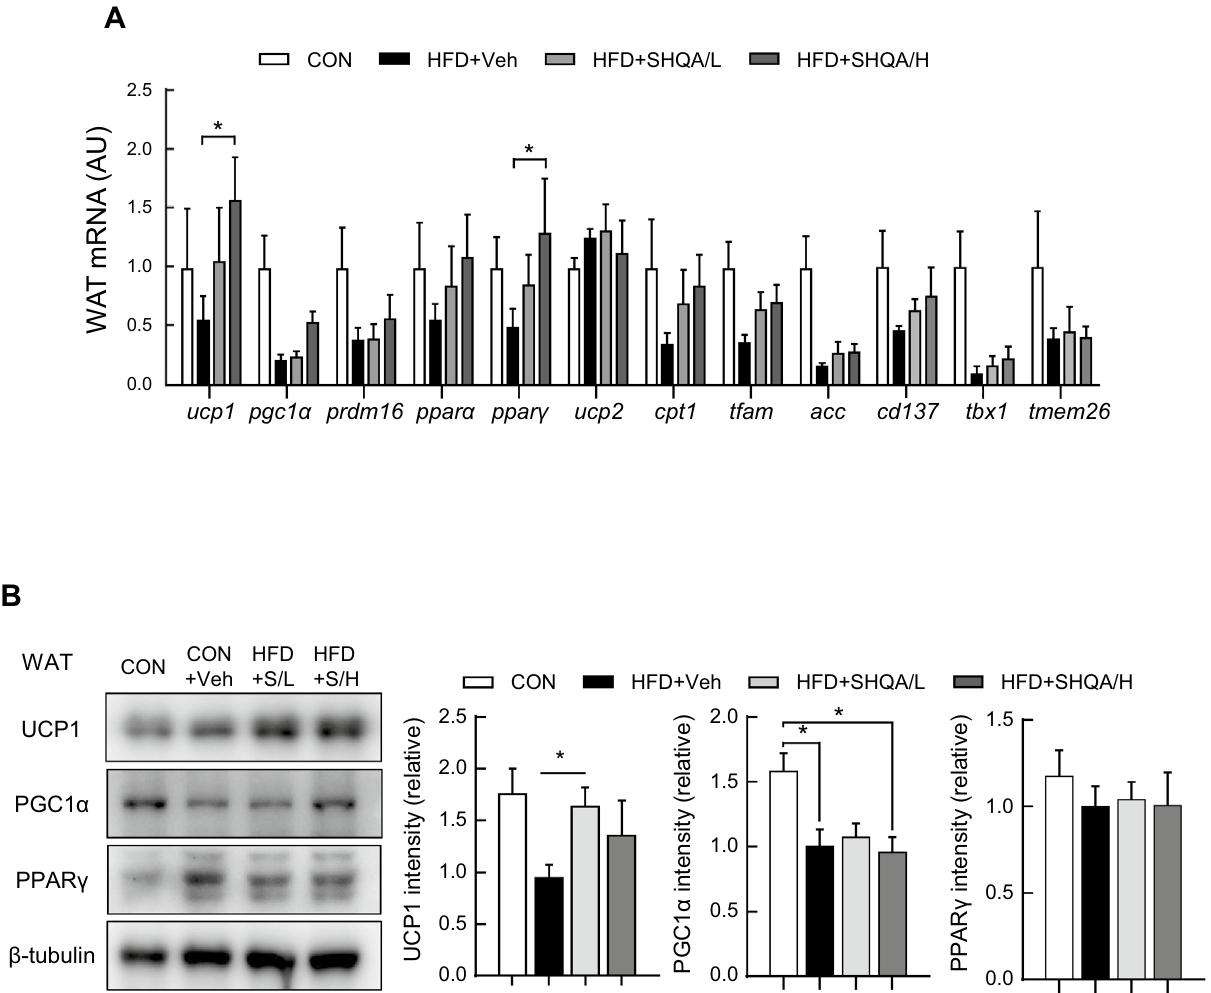
Figure 6. SHQA injection alters gene expression signature in white adipose tissues of mice. C57BL/6 mice (4 weeks old) were fed a chow diet (CON) or a HFD with the hypothalamic injection of PBS (CON or HFD + Veh, three times a week), a low dose (HFD + SHQA/L or HFD + S/L, 20 ng/µl, three times a week) or a high dose of SHQA (HFD + SHQA/H or HFD + S/H, 100 ng/µl, three times a week) for 12 weeks. The subcutaneous white adipose tissues from these mice were collected for measuring mRNA and protein levels. ( A ) mRNA expression levels of genes related to adipose tissue browning and thermogenesis were measured in white adipose tissues. ( B ) The protein levels of UCP1, PGC1α, and PPARγ were measured by western blots with representative bands shown in the figure (whole images of blot were shown in Supplementary Fig. S2). Data are expressed as mean ± S.E.M. Statistical differences between CON, HFD + Veh, HFD + SHQA/L (SHQA, 20 ng/µl), and HFD + SHQA/H (SHQA, 100 ng/µl) were determined using one-way ANOVA followed by the Tukey’s post hoc test: * p < 0.05; Statistical differences between HFD + Veh and HFD + SHQA/L in UCP1 protein were determined using two-tailed student’s t test: * p < 0.05; n = 6–7 mice for qPCR ( A ) and n = 4–5 for western blotting ( B